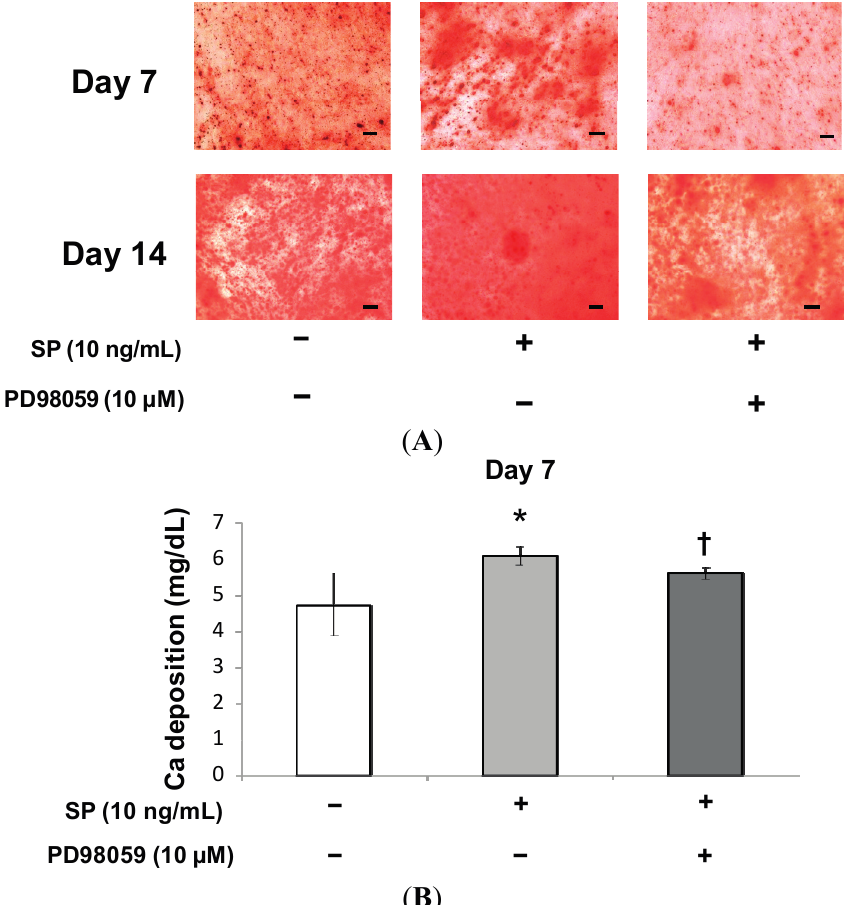
Figure 8. Effect of SP on mineralization. ( A ) Confluent MSCs were stained with Alizarin Red after 7 or 14 days of cultivation in osteogenic medium containing SP (0 or 10 ng/mL), or SP (10 ng/mL) with the ERK 1/2 inhibitor, PD98059 (10 µM). Scale bar = 100 µm; ( B , C ) The extracellular calcium deposition was measured at 7 or 14 days. * p < 0.05, SP (0 ng/mL) vs. SP (10 ng/mL), † p < 0.05, SP (10 ng/mL) vs. SP (10 ng/mL) with PD98059 (10